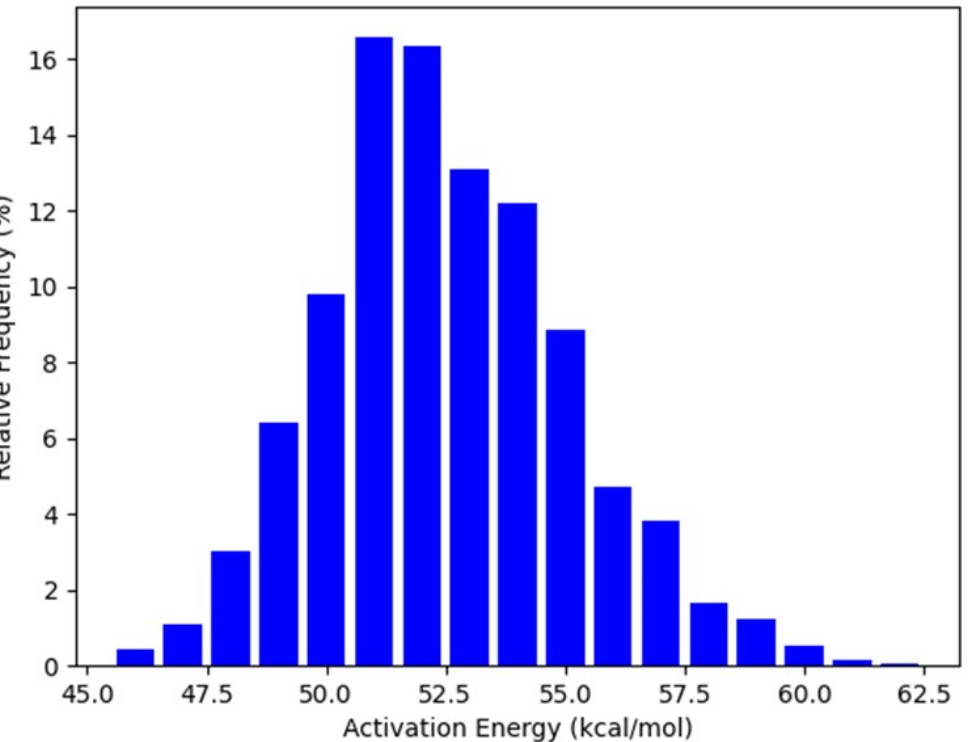
Figure 12. Kerogen activation energy distribution used in the Montney Formation basin model. The model was derived from the Doig Formation and is described in detail in Silva (2021). The median activation energy was calculated as being 52 kcal/mol, with a pre-exponential factor of 1.81 × 10 25 /Ma.